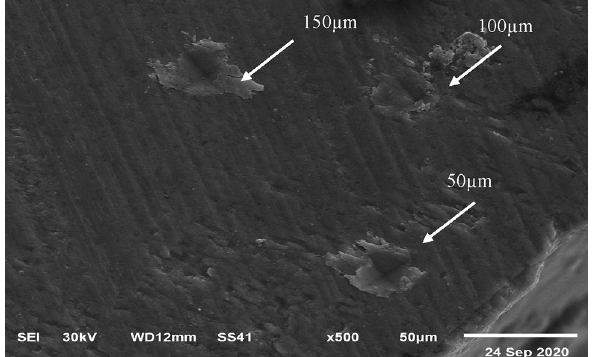
Figure 2. SEM micrograph showing microhardness indentations at 50, 100, and 150 µm (white arrows) from the external enamel surface. Micro-Raman spectroscopy and EDX were performed at the same points.